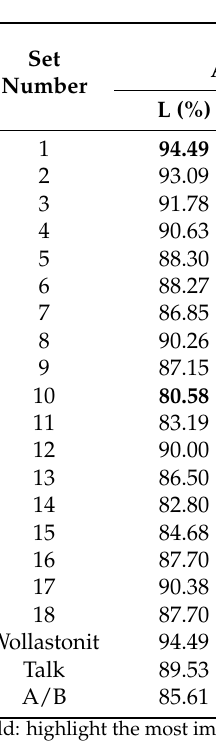
Figure 10. Whiteness of the system A/B-eutectic–talc–wollastonite. From the obtained data, it can be read (Table 5) that the highest value of the color parameter L = 94.49% was registered for the sample No. 1 with the composition of 80% Wollastonite 95 and 20% Luzenac A10H (the sample does not contain a Li–Na–K mixture in its composition), and the lowest value of 72.45% for the composition of 18 B-eutectic. The whiteness depends on the degree of sintering of the sets and their compositions. The measurements showed the highest whiteness for the sets containing increased amounts of wollastonite. Furthermore, talc clearly improves the whiteness. In general, the lower the degree of sintering, the higher the whiteness. Table 5. Values of color components (%) in the system L a b of the investigated